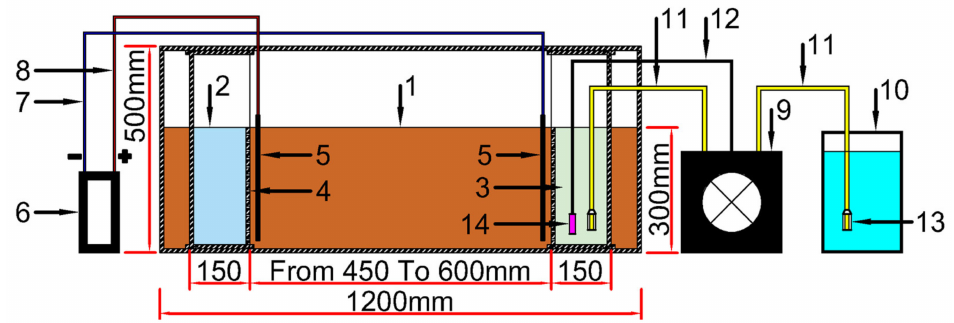
Figure 4. The physical model dimensions show the following: ( 1 ) soil sample, ( 2 ) anode (CaCl 2 solution), ( 3 ) cathode (urea and bacteria solution), ( 4 ) perforated wall of the cell, ( 5 ) graphite rod,